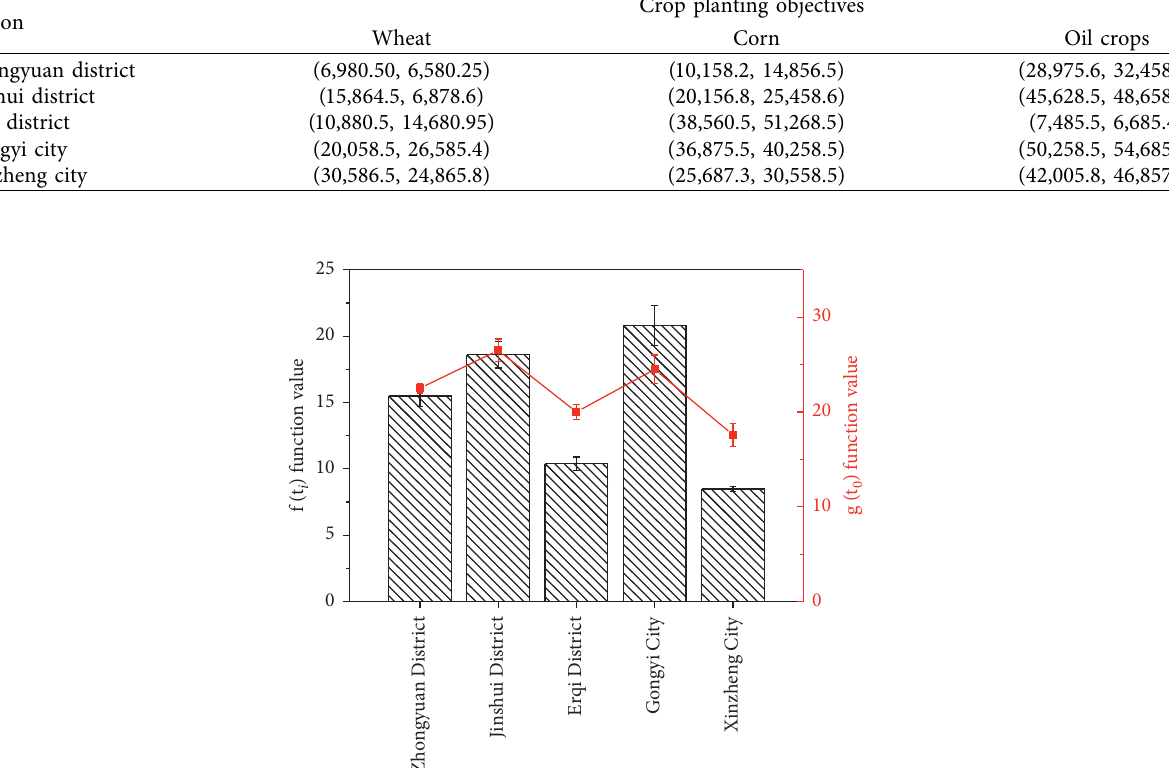
Crop planting objectives